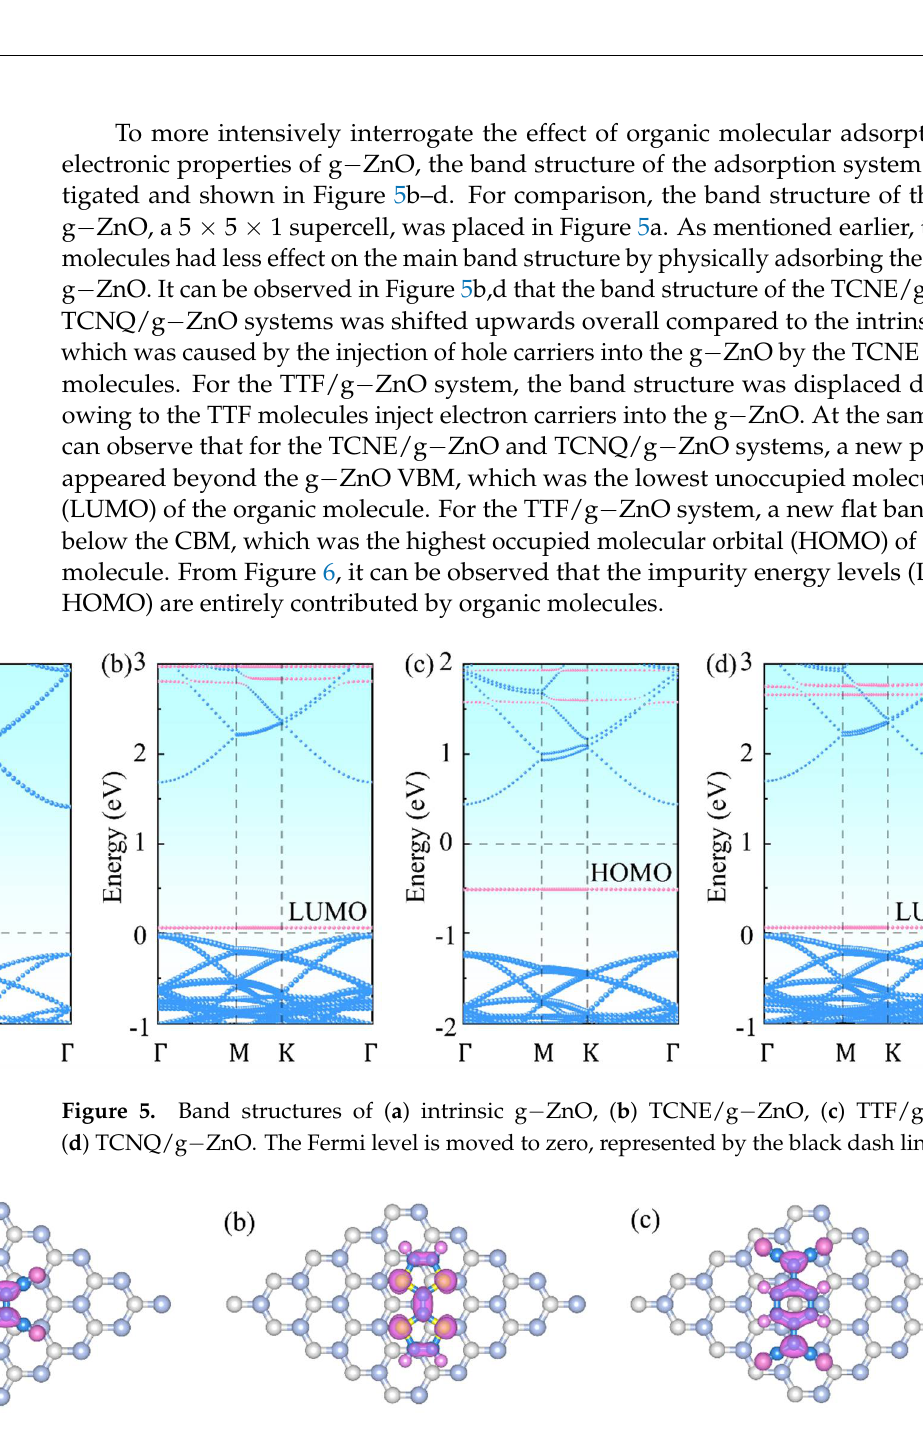
Figure 6. The partial charge densities of ( a ) TCNE/g−ZnO, ( b ) TTF/g−ZnO, and ( c ) TCNQ/g−ZnO systems (The purple area delegates the partial charge density corresponding to impurity bands).